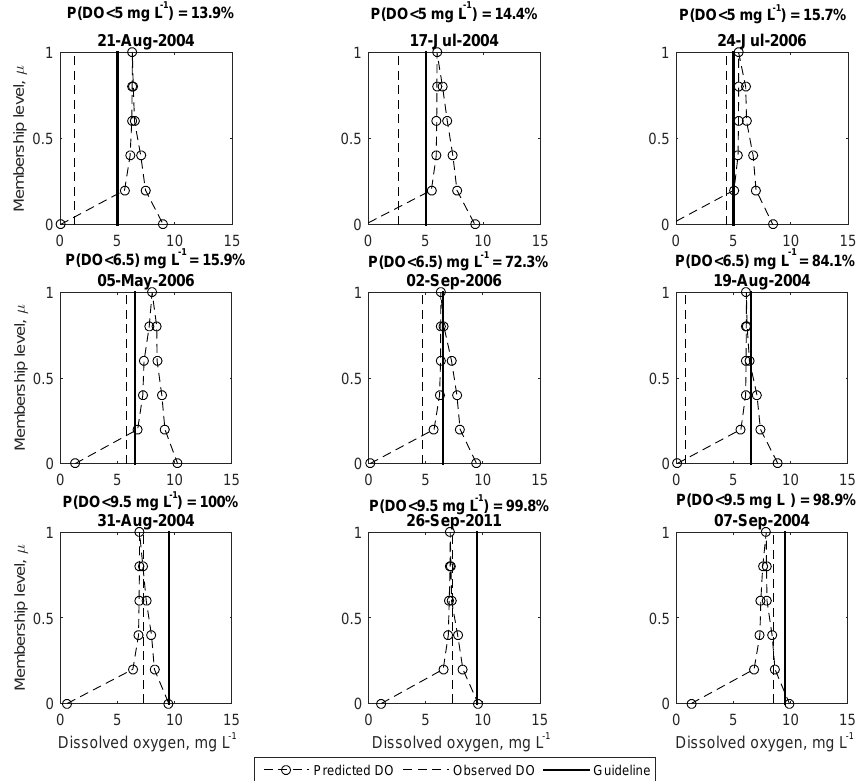
Figure 12. Sample plots of low DO events and the corresponding risk of low DO calculated using a possibility–probability transformation for the 5mgL − 1 (top panels), 6.5mgL − 1 (middle panels), and 9.5mgL − 1 (bottom panels)